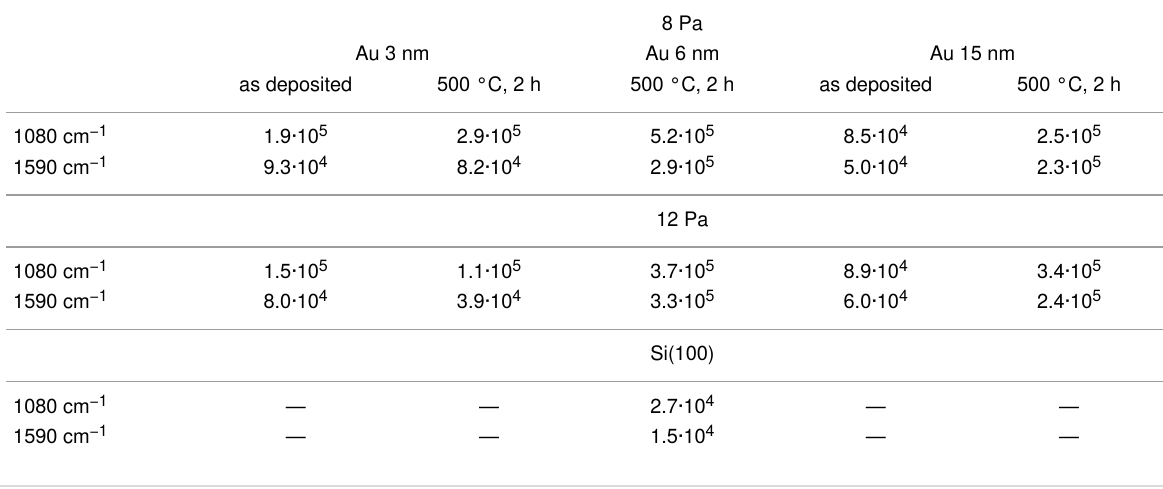
Table 3: Enhancement factor values for MBA, calculated for the peaks at 1080 and 1590 cm − 1 .